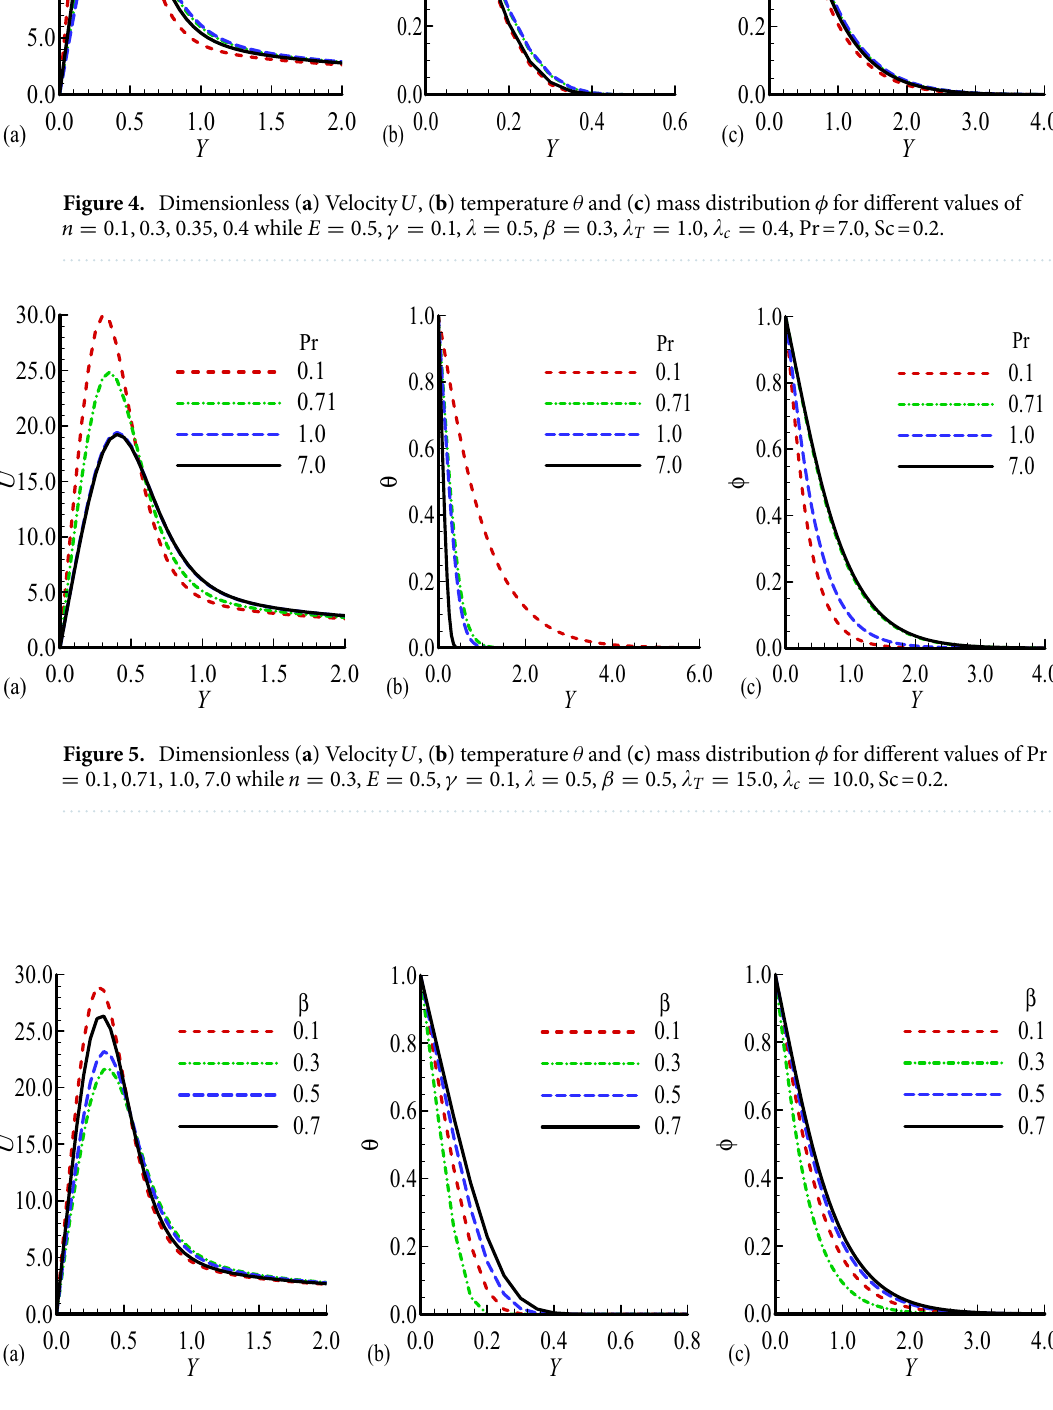
Figure 6. Dimensionless ( a ) Velocity U , ( b ) temperature θ and ( c ) mass distribution φ for different values of β = 0.1, 0.3, 0.5, 0.7 while n = 0.3 , E = 0.2 , γ = 0.2 , (cid:31) = 0.4 , (cid:31) T = 10.0 , (cid:31) c = 10.0, Pr = 7.0, Sc =